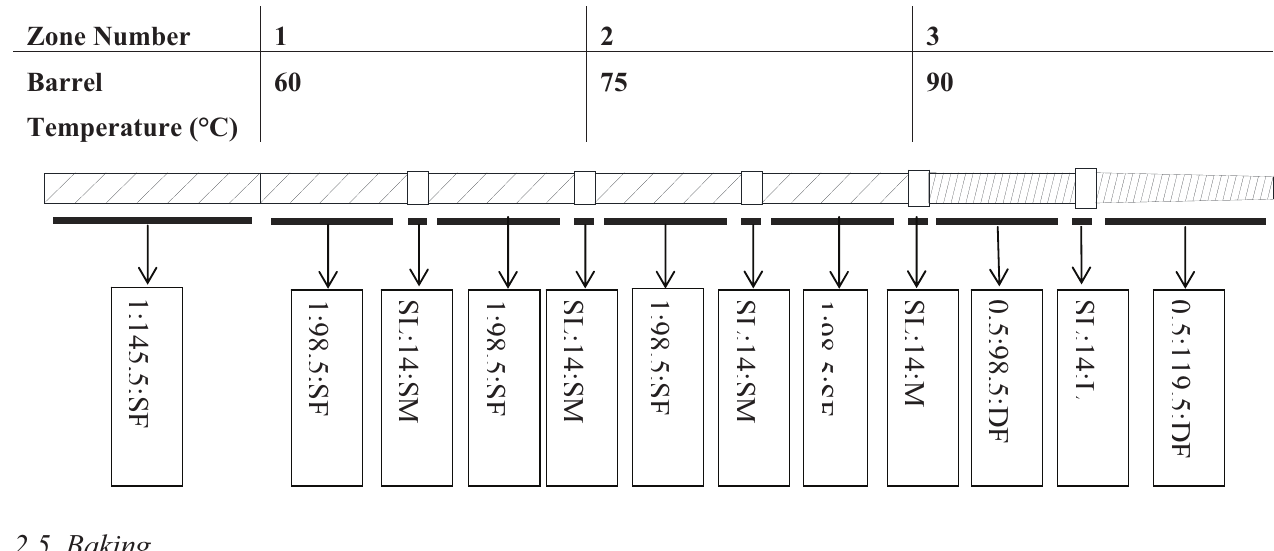
Figure 1. Schematic showing pilot scale single screw extruder profile and barrel temperature setting. The screw element codes a:b:x imply the following: a = 1 (full pitch screw), 0.5 (half pitch screw), SL (steam lock element); b = element length (mm); x = SF (single flighted screw), DF (double flighted screw), SM (small diameter steam lock), M (medium diameter steam lock), L (large diameter steam lock). The last screw element is a conical shaped